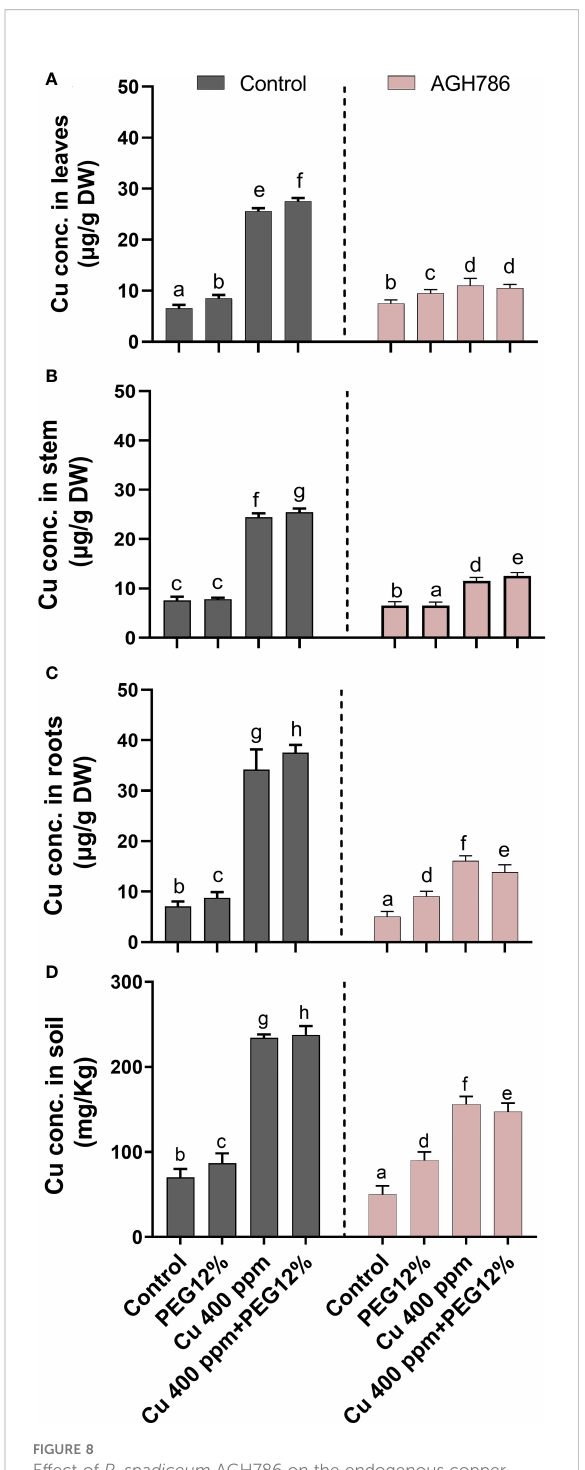
FIGURE 8 Effect of P. spadiceum AGH786 on the endogenous copper accumulation in various tissues of S. lycopersicum L. under heavy metal (Cu) toxicity and drought stress (12% PEG). (A) Cu accumulation in leaves. (B) Cu concentration in the stem. (C) Cu concentration in roots. (D) Concentration of Cu in soil. Data represent the mean with standard error, and letters represent the signi fi cant difference (p <